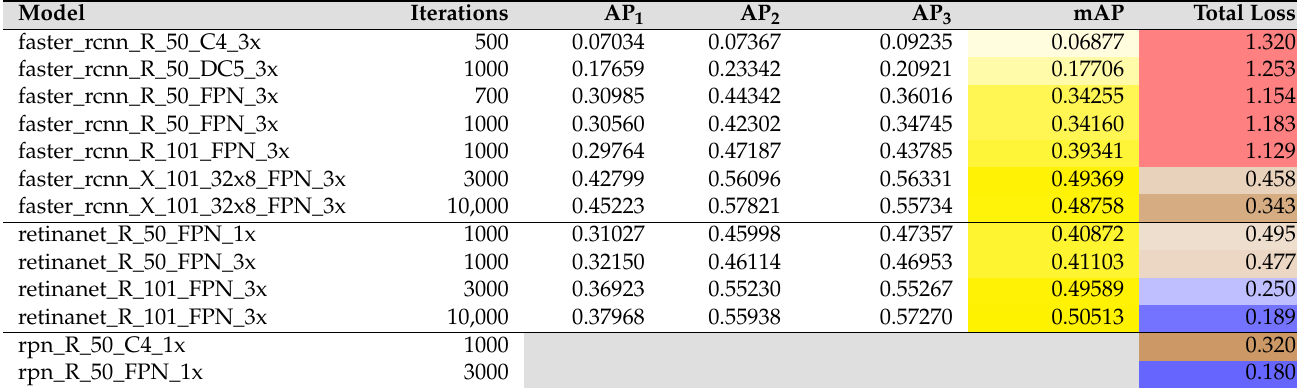
Table 1. Detectron Phase 1 Experiments and Results.